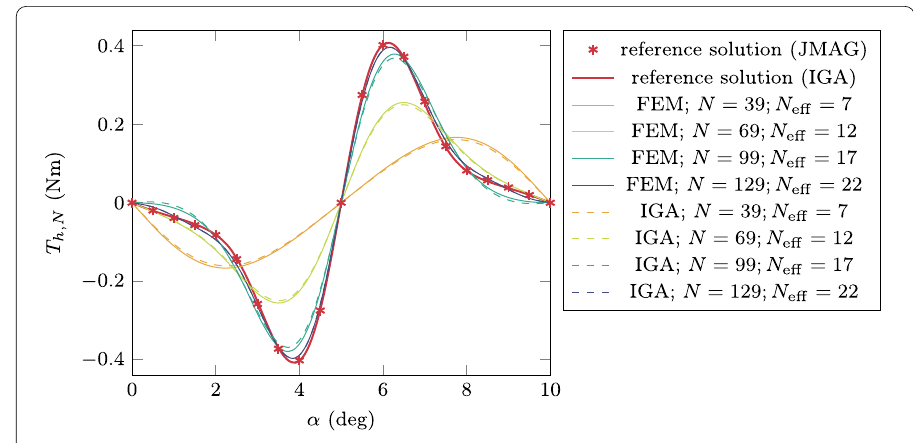
Figure 3 Cogging torque of the machine. Computed using trigonometric polynomials of degree N as basis for the Lagrange multiplier space. Computed with FEM and IGA using basis functions of degree p = 1,2